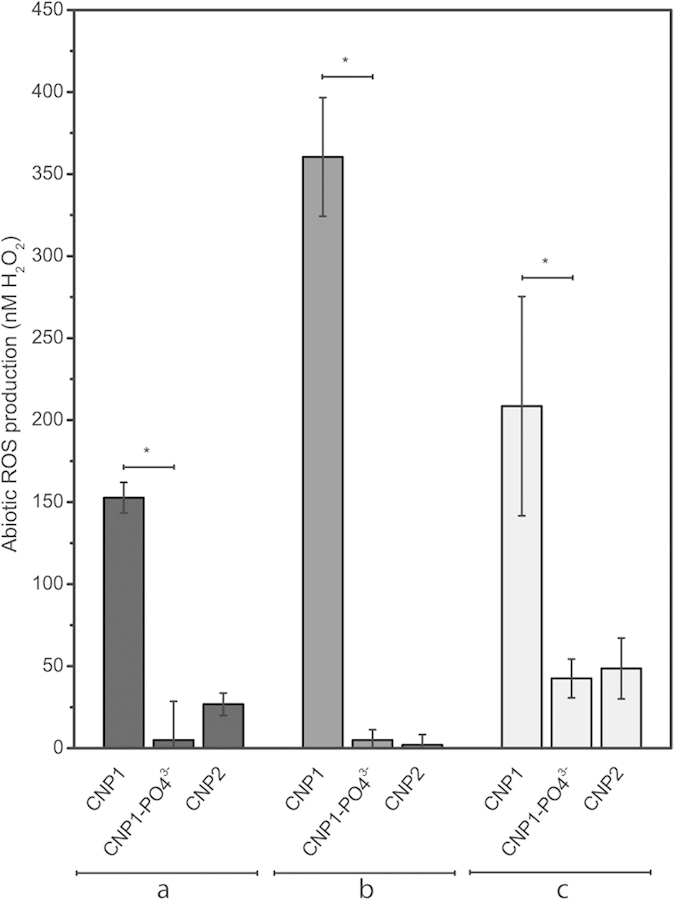
ROS production by 10 mgL−1 CNPs in ddH2O (a), in OECD-medium (b) and OECD-medium after 24h exposure to P. subcapitata to CNP1, CNP2 and CNP1-PO43− (c) assessed by OxiSelect™ in vitro ROS/RNS Assay Kit.ROS/RNS was expressed as H2O2 equivalent concentration.